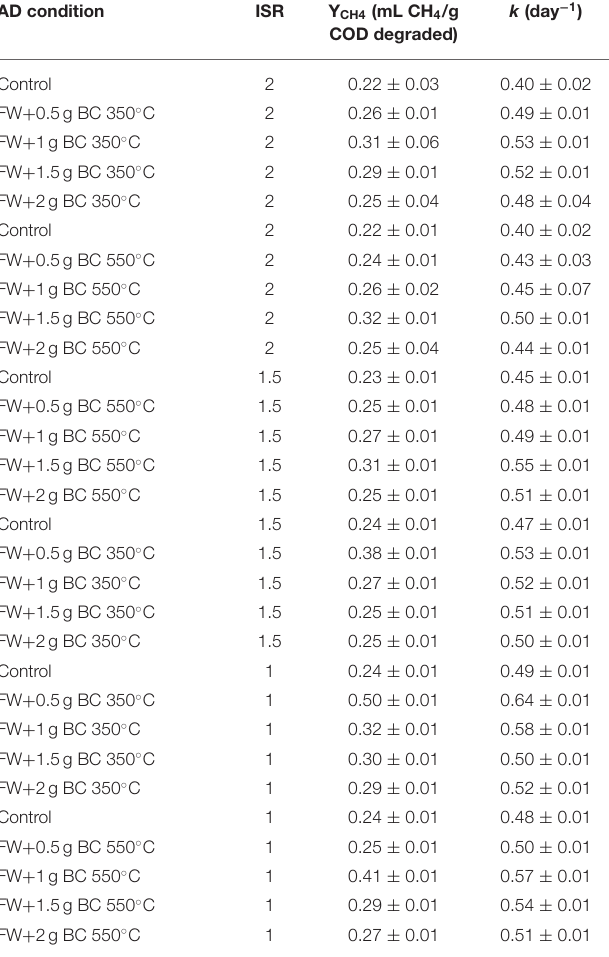
TABLE 8 | Methane yield (Y CH4 ) and rate constant (k) for different AD conditions for ISR 2, 1.5, and 1. AD condition